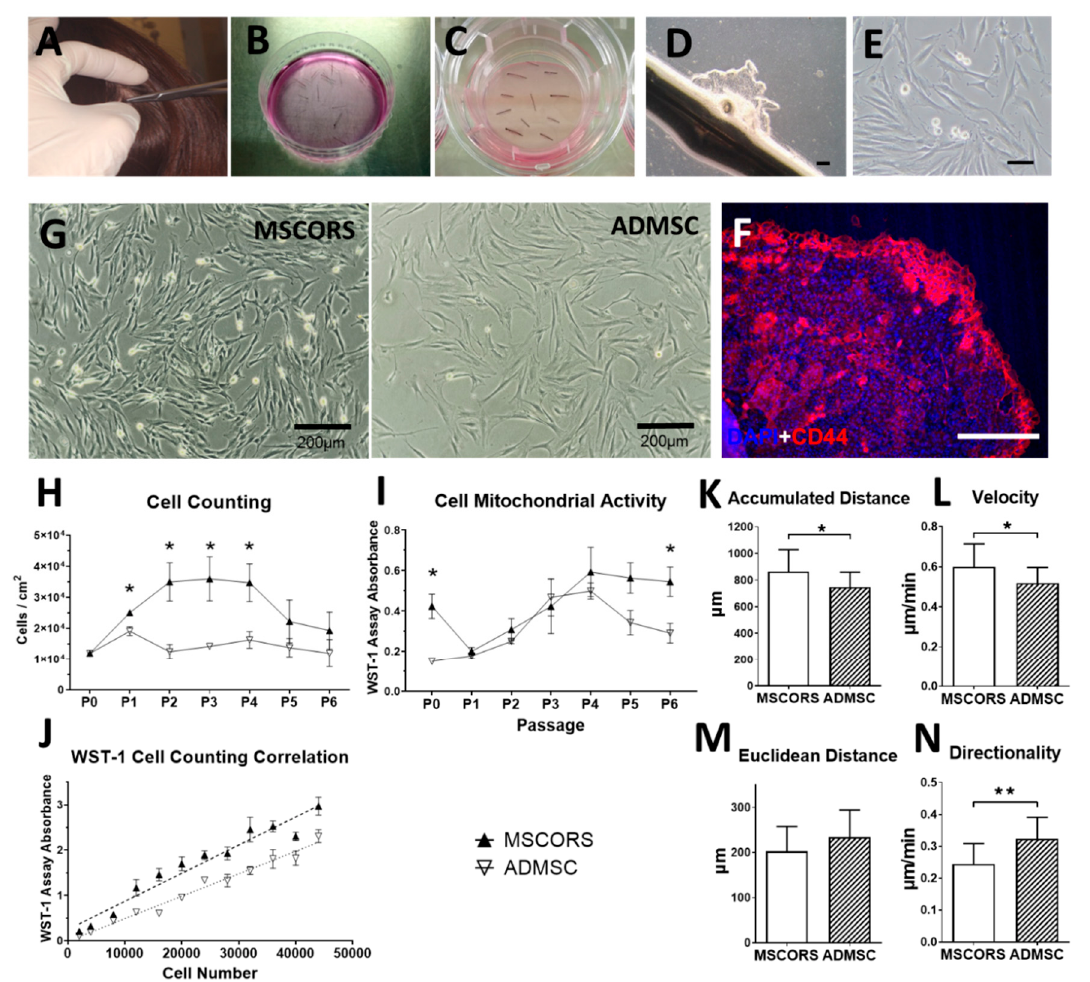
Figure 1. Isolation and cultivation of MSCORS compared to ADMSC. Hair follicles were plucked from the human scalp of five healthy donors ( n = 5) in double harvesting sessions of 60 hairs per session ( A ), shortened distally and proximally, washed ( B ), and explanted on a Transwell membrane ( C ). From day 3 to day 24, cells migrated out from the ORS and formed a cell monolayer with a colony-like structure ( D ). Upon reaching confluence, the ORS cell monolayer was subcultured in flasks ( E ). ( F ): The ORS cell monolayer was positive for CD44 (red) with intensive expression at the outer ORS edge. ( G ): After subcultured in a flask, MSCORS displayed an MSC-like morphology similar to ADMSC. Serial cell subcultures of MSCORS and ADMSC over 1–6 passages, with cell counting ( H ) and projected cell yield ( I ) in each passage, correlated with cell mitochondrial activity ( J ). Cell migration of MSCORS and ADMSC, including accumulated distance ( K ), velocity ( L ), Euclidean distance ( M ), and directionality ( N ). Data are shown as mean ± SD (* p < 0.05, ** p < 0.01) ( n = 5), with unpaired t -test or nonparametric Mann–Whitney test. Scale bar corresponds to 200 μ m; magnification ( A ) 2×, ( E , F ) 10×, and ( G ) 4×.